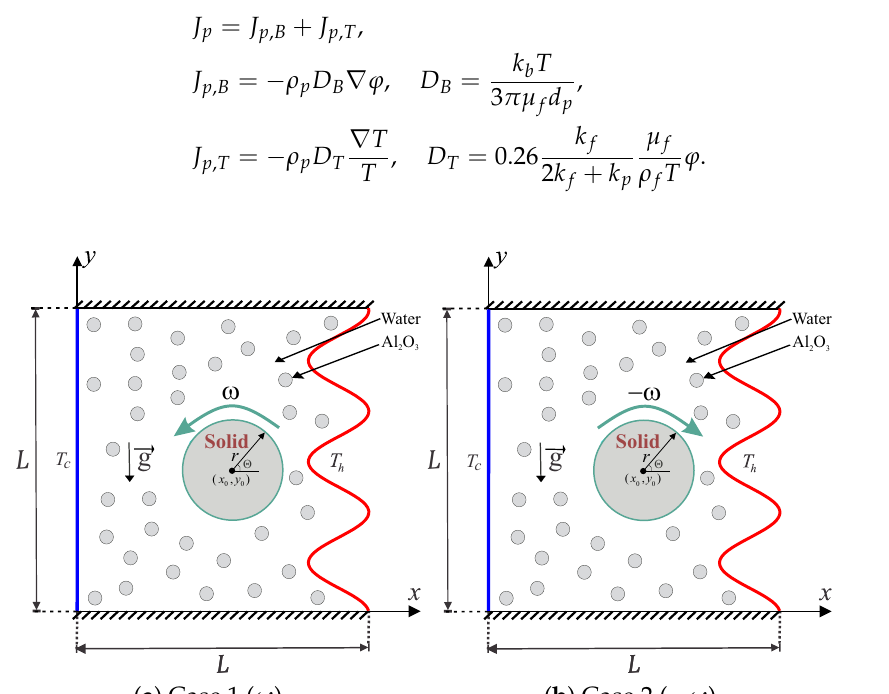
Figure 1. Schematic diagram of the physical model together with the coordinate system for: ( a ) Case 1, counterclockwise (CCW); and ( b ) Case 2, clockwise